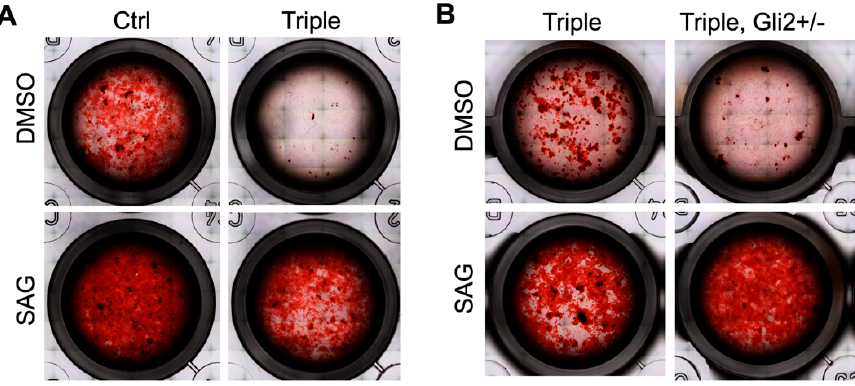
Figure 5. Amelioration of in vitro bone formation defect in Thm2 − / − ; Thm1 aln/+ osteoblasts by Hh agonist. Images of bone nodules on day 21 of an in vitro differentiation assay using calvarial-derived osteoblasts of P10 ( A ) control and Thm2 − / − ; Thm1 aln/+ littermates and ( B ) Thm2 − / − ; Thm1 aln/+ and Thm2 − / − ; Thm1 aln/+ ; Gli2 +/ − littermates. Media was supplemented with either DMSO (control) or Hh agonist (SAG) throughout the differentiation assay. n = 4 control, n = 4 triple, n = 2 triple; Gli2 +/ − from 3 litters.